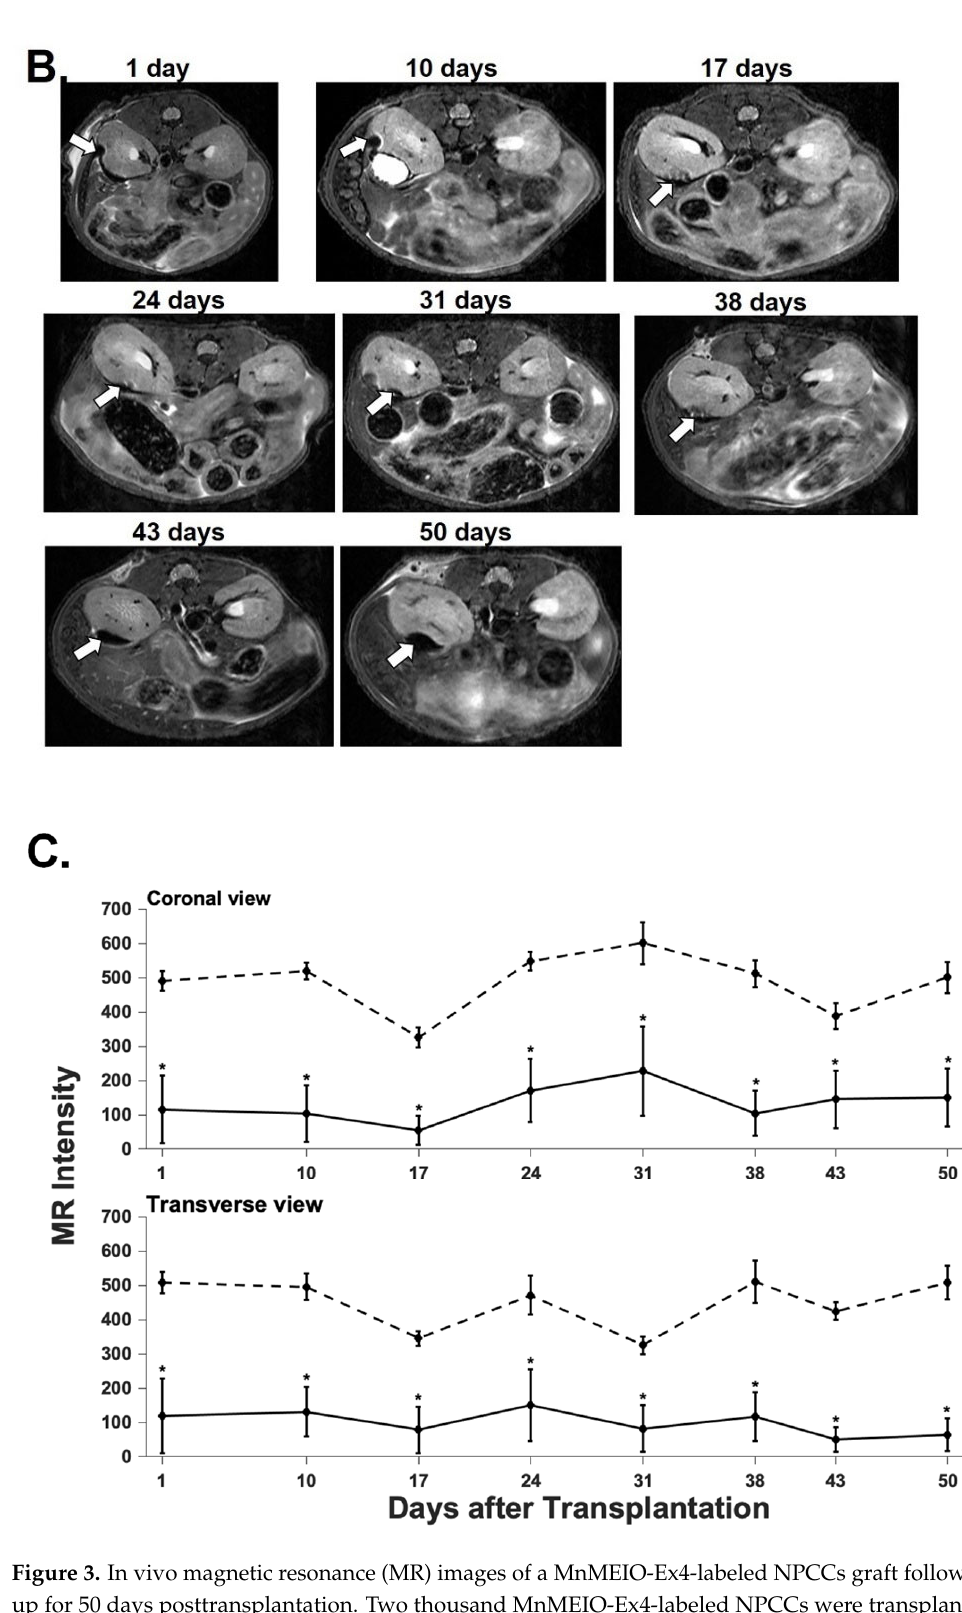
Figure 3. In vivo magnetic resonance (MR) images of a MnMEIO-Ex4-labeled NPCCs graft followed- up for 50 days posttransplantation. Two thousand MnMEIO-Ex4-labeled NPCCs were transplanted under the left kidney capsule of a nude mouse. The recipient was scanned by a 7.0 T MRI machine with coronal ( A ) and transverse ( B ) sections. The graft was indicated by arrows. ( C ) The time course of the MR signal intensity of the graft on left kidney (solid line) and the mirror area on the contralateral kidney (dash line) in the mouse. * p < 0.001.